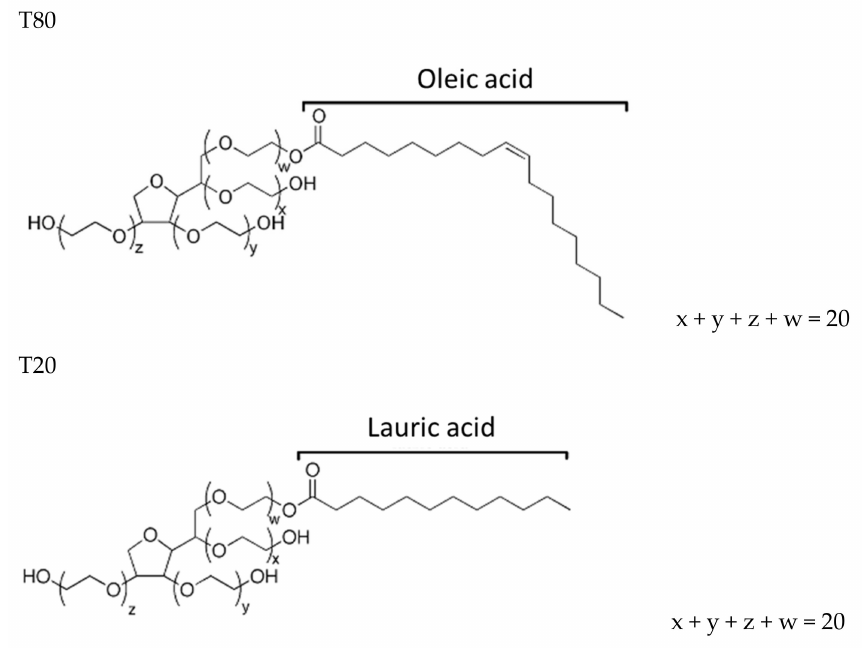
Figure 1. Chemical structure of the polysorbate